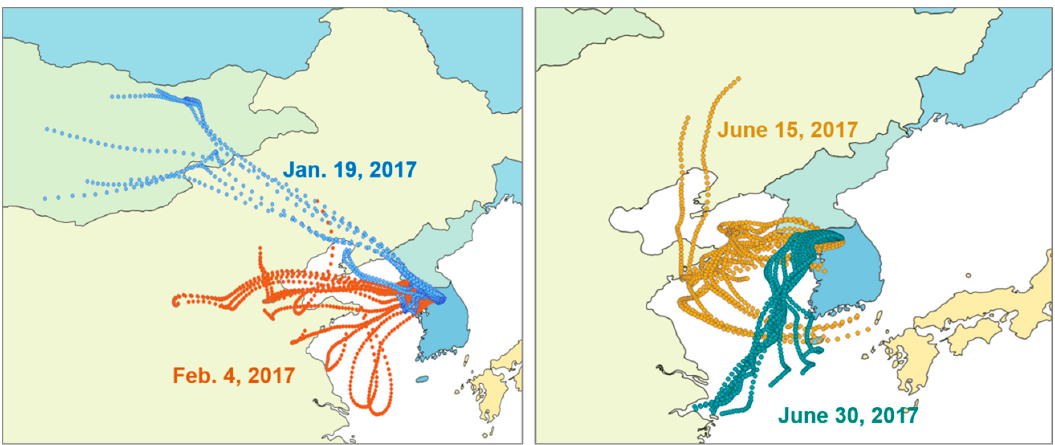
Figure 6. Backward trajectories of the high concentration episode (HCEs).